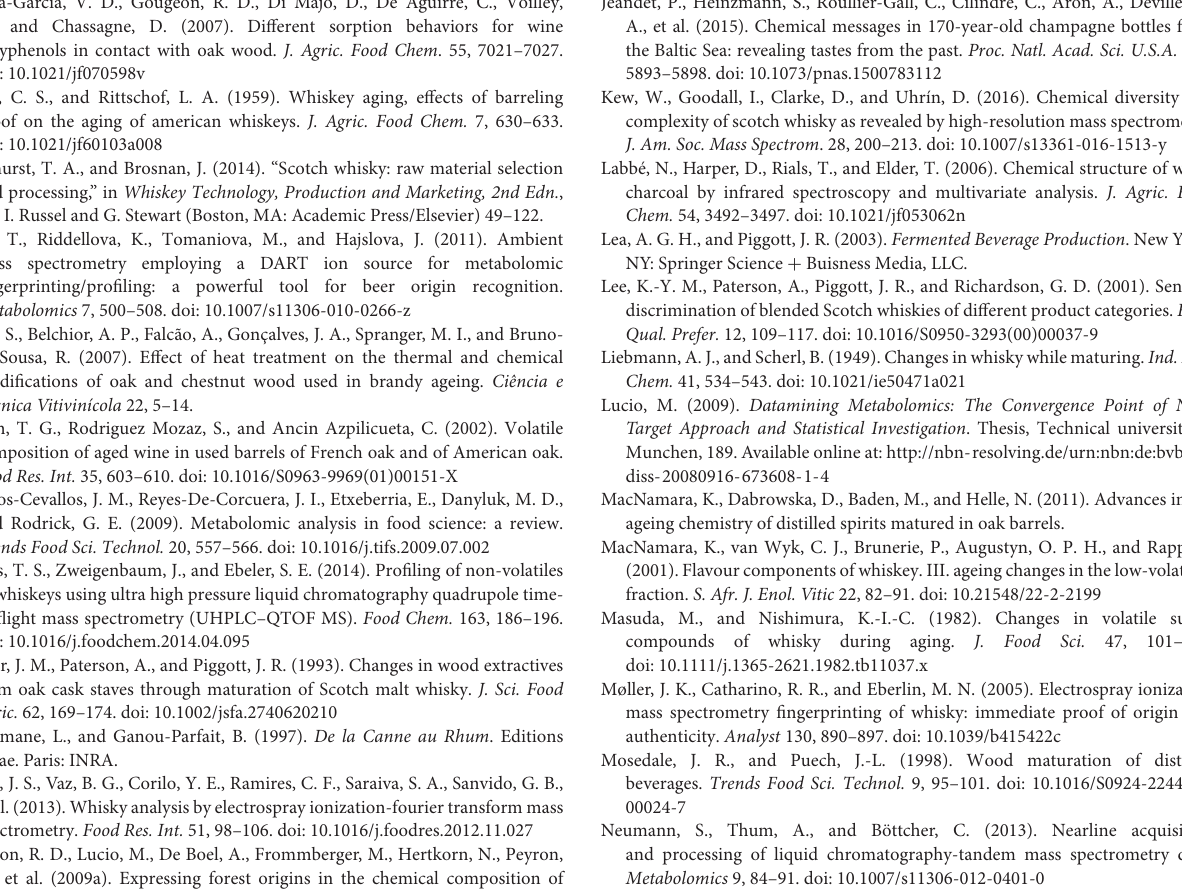
variation of intensities of formulas detected among the ten injections of QC sample and frequency of the common detected formulas over the 10 QCs (all the ten QC samples in green, higher than in 5 samples in blue and lower than 5 samples in gray).